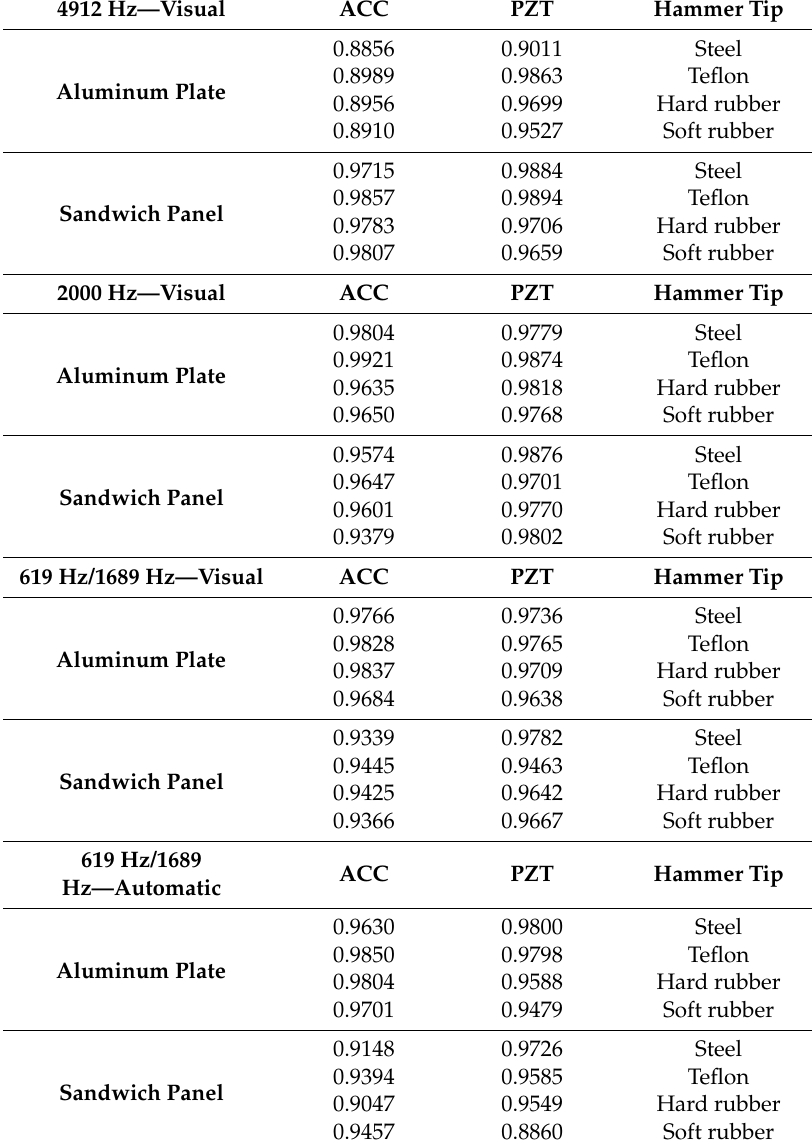
Table A2. Pearson coefficients for the datasets obtained with the ACC and PZT sensor, for the visual and the automatic